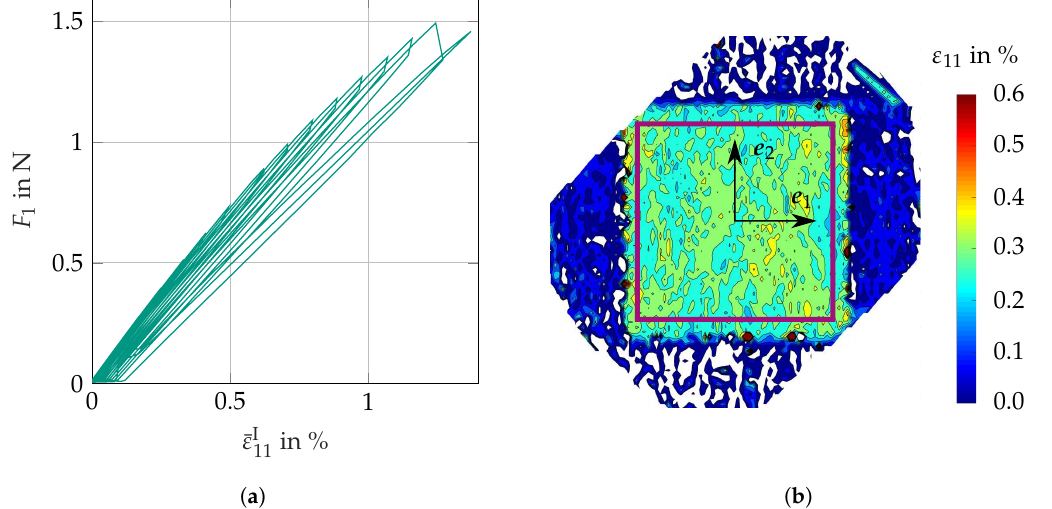
Figure 14. Geometry 1 with continuous fiber reinforced arms with loading scenario P Γ = 0 . ( a ) Force F 1 in e 1 -direction over averaged normal strain ¯ ε I in the area of interest; ( b ) Contour plot of the normal 11 = 0.3%. strain ε 11 at ¯ ε I 11